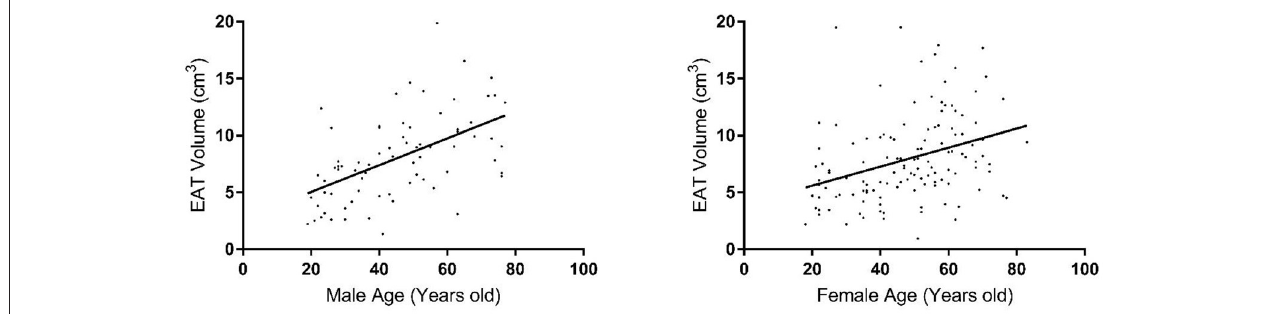
FIGURE 1 | Distribution of epicardial fat volume in males (left plot) and females (right plot) by age